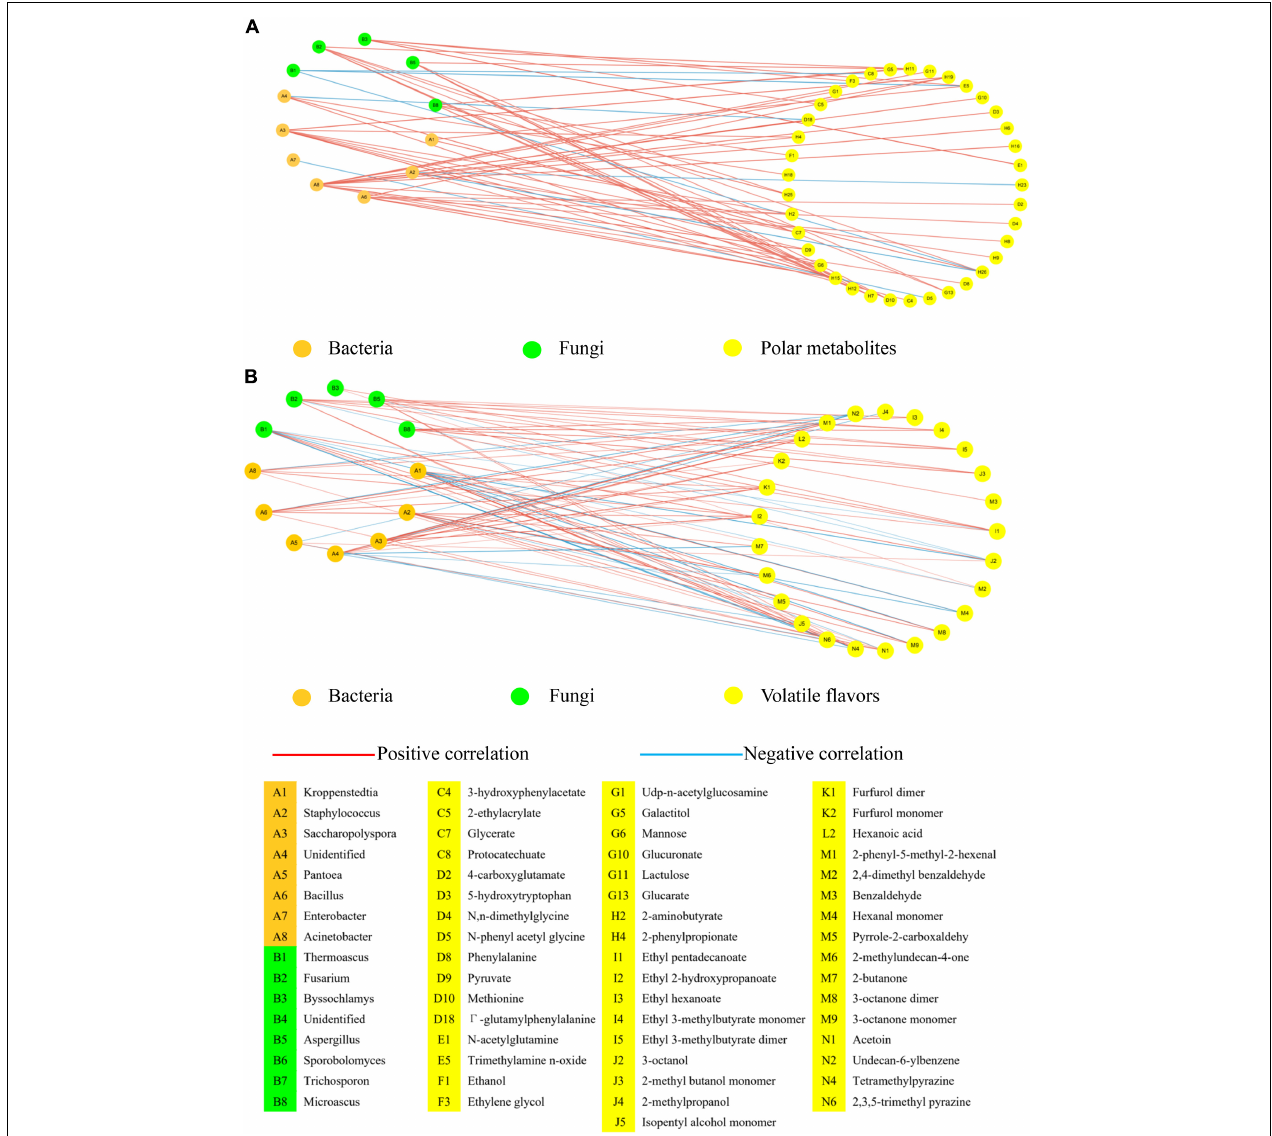
FIGURE 4 | Network analysis of the interactions among microbiota, polar metabolites ( 1 H NMR) and volatile flavors (HS-SPME-GC-MS and HS-GC-IMS). (A) The correlated network between microbiota and polar metabolites. (B) The correlated network between microbiota and volatile flavors. Population data was considered at the OTU level and statistically significant Pearson correlations were calculated among Daqu samples. A connection stands for a significant ( P < 0.05) and positive (Pearson correlation > |0.7|)